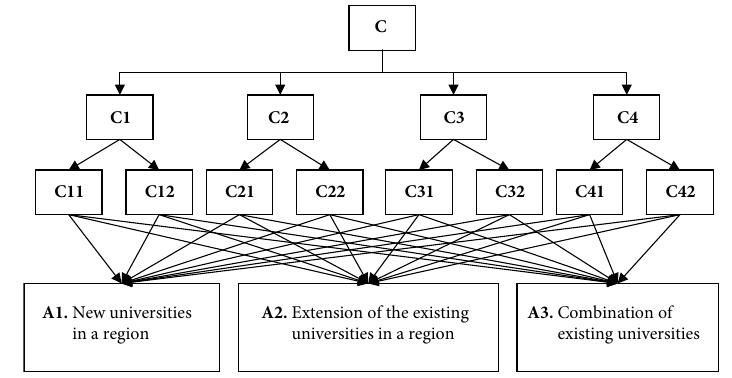
Fig. 2. Hierarchy of criteria and